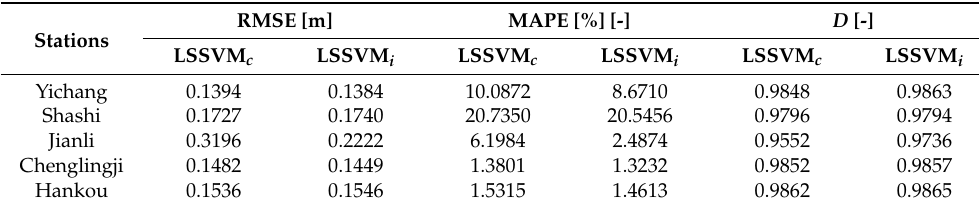
Table 1 . Parameters of the LSSVM i (least squares support vector machine) model with regard to different forecast lead times.